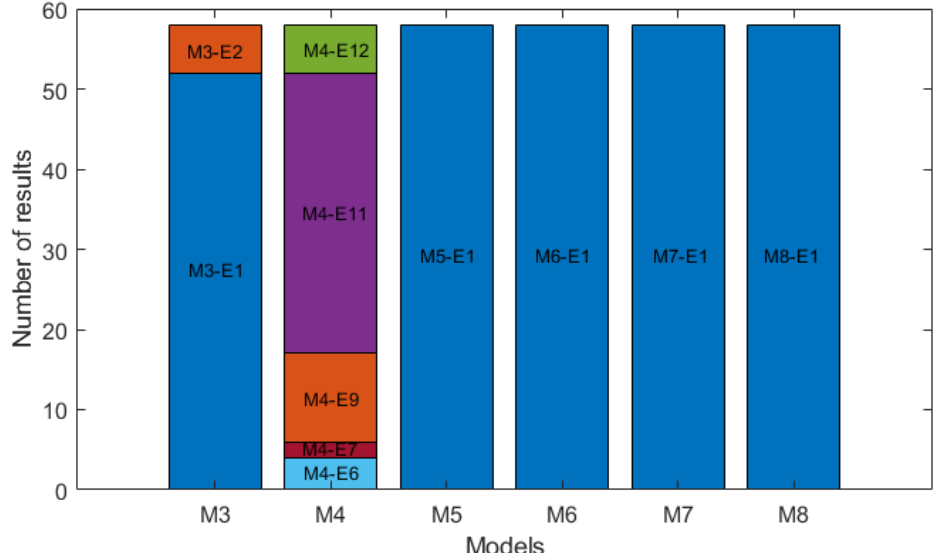
Figure 9. Selected submodels (equations) for validation (M3–M8).